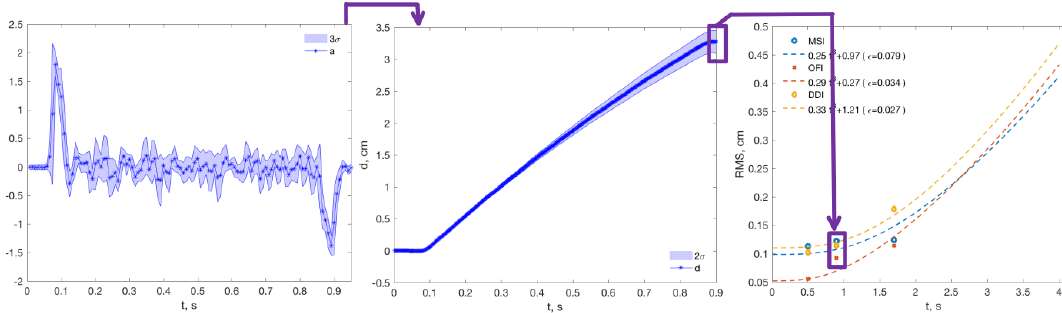
Figure 3. The complete experimental procedure: ( Left ) the accelerometer signals were segmented and analyzed, and the erroneous one was discarded; ( Center ) the estimation methods were applied, and the RMS value was computed at the end of the motion; ( Right ) RMS values were compared for different integration times, sensors, and methods.